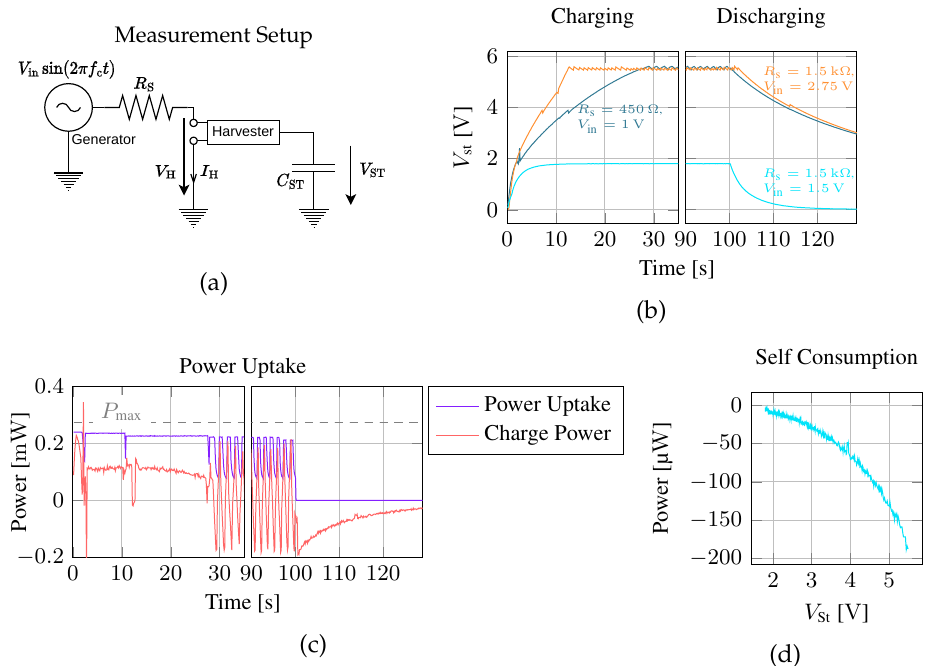
Figure 10. The measurement setup is shown in ( a ), and charge curves ( b ) show the voltage at the storage capacitor over time. The power consumed by the harvester is suboptimal ( c ), and the PMU consumes part of the power itself. The self-consumption is dependent on the voltage at the storage capacitor ( d